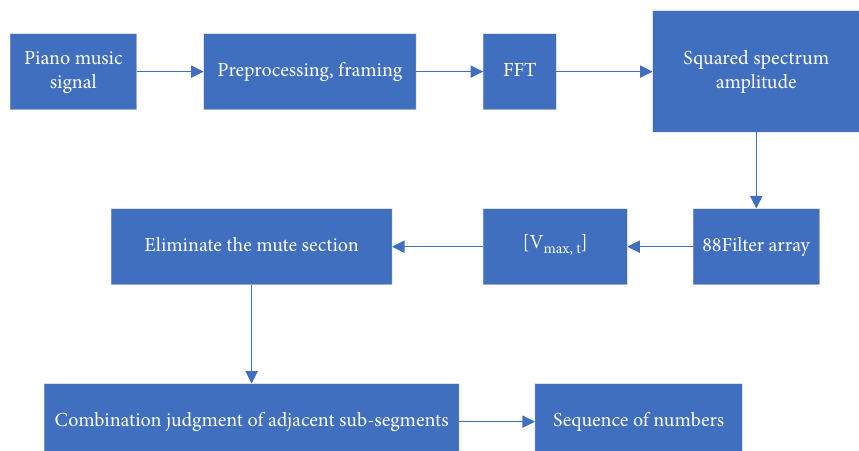
Figure 1: MFCC extraction